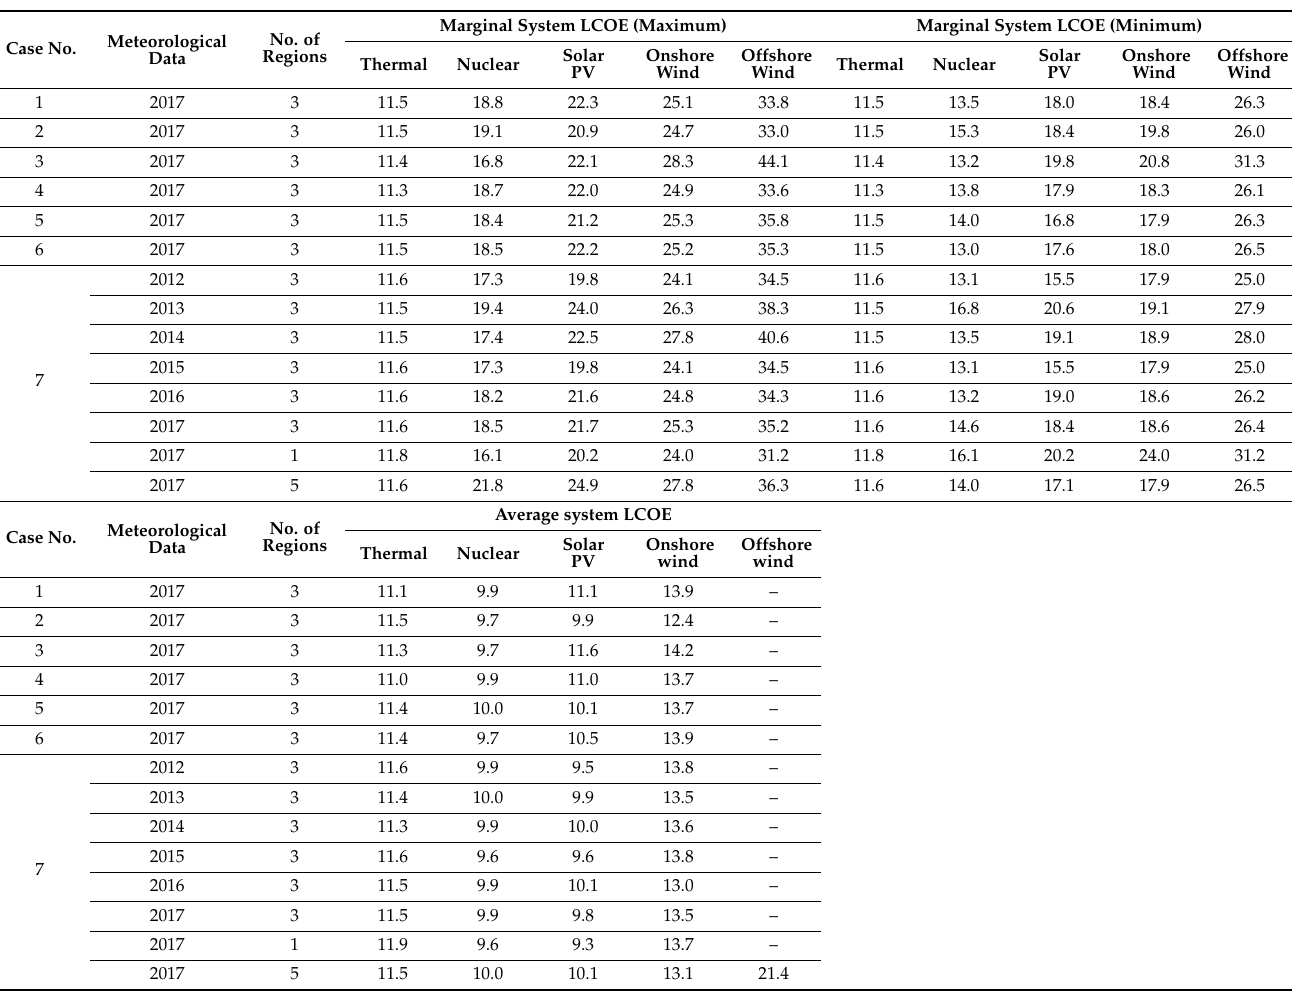
Table 2. Results with 50 TWh thermal power generation by